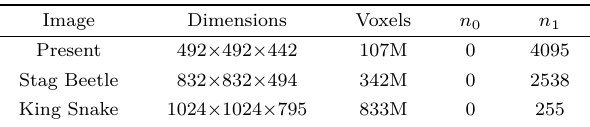
Table 1 Dimensions of evaluated volumetric images and normalisa- tion constants Image